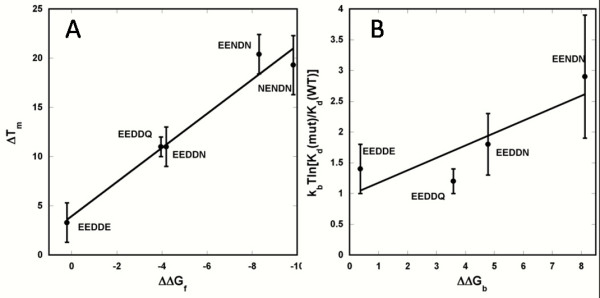
Electrostatics calculations. (A) Correlation of observed Tm values of the apo-7E15 variants and calculated changes in folding energy. (B) Correlation of calculated (ΔΔGb) and experimental results for mutational effects on binding free energy. The error bars are for experimental measurements.